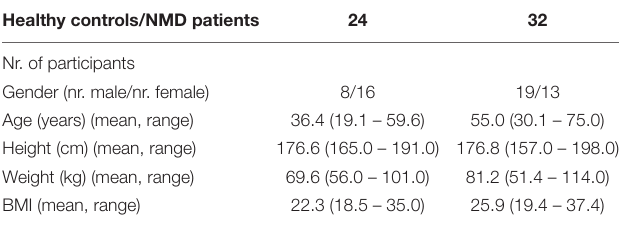
TABLE 1 | Participant